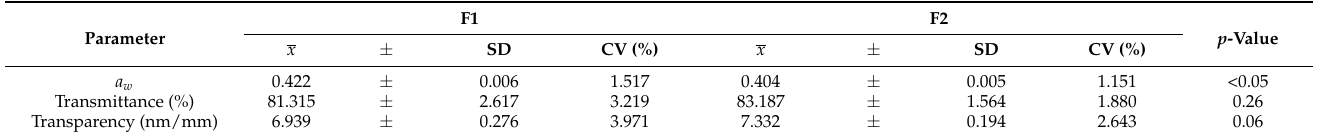
Table 2. Water activity and transparency (nm/mm) of the films.